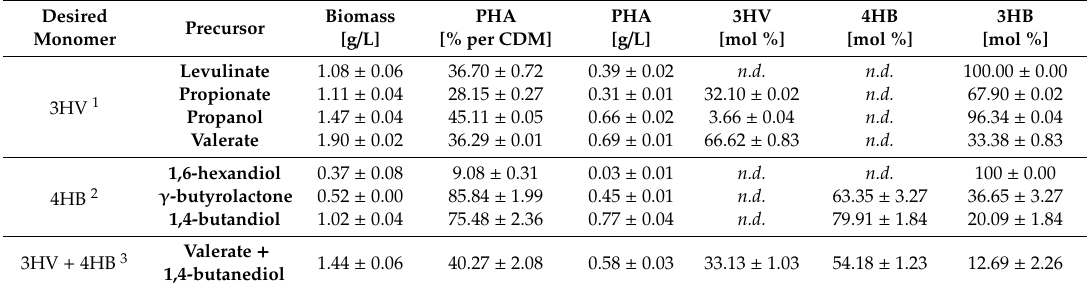
Table 4. Production of PHA copolymers and terpolymer using various precursors of 3HV and 4HB. Desired